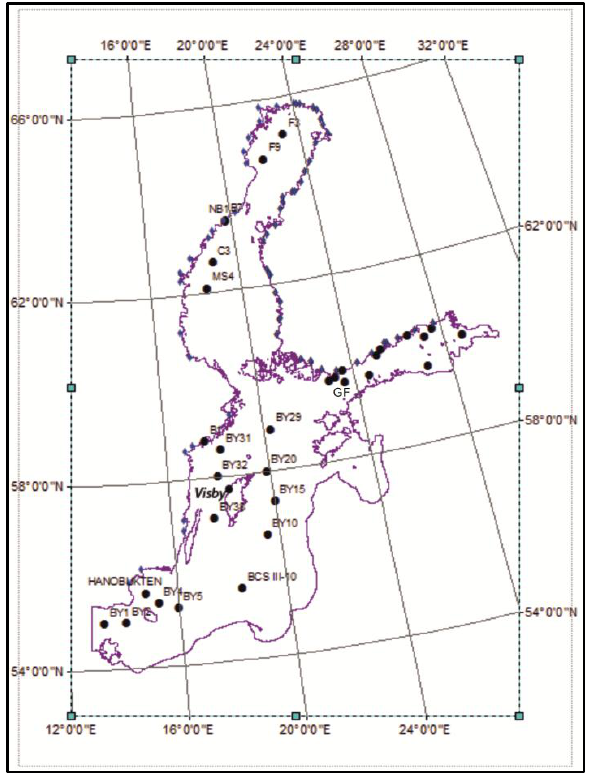
Figure 3. Map showing the monitoring stations in the Baltic Sea.